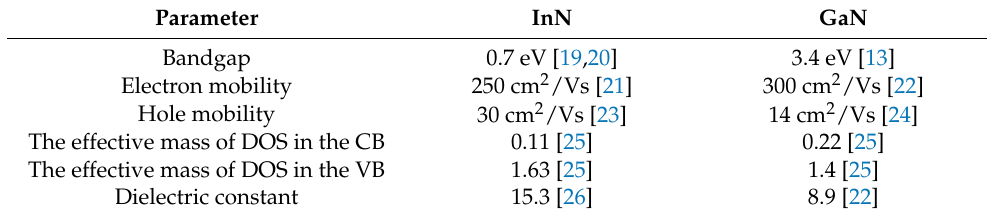
Table 1. Parameters of the binary compounds. Parameter InN GaN Bandgap 0.7 eV [19,20] 3.4 eV [13] Electron mobility 250 cm 2 /Vs [21] 300 cm 2 /Vs [22] Hole mobility 30 cm 2 /Vs [23] 14 cm 2 /Vs [24] The effective mass of DOS in the CB 0.11 [25] The effective mass of DOS in the